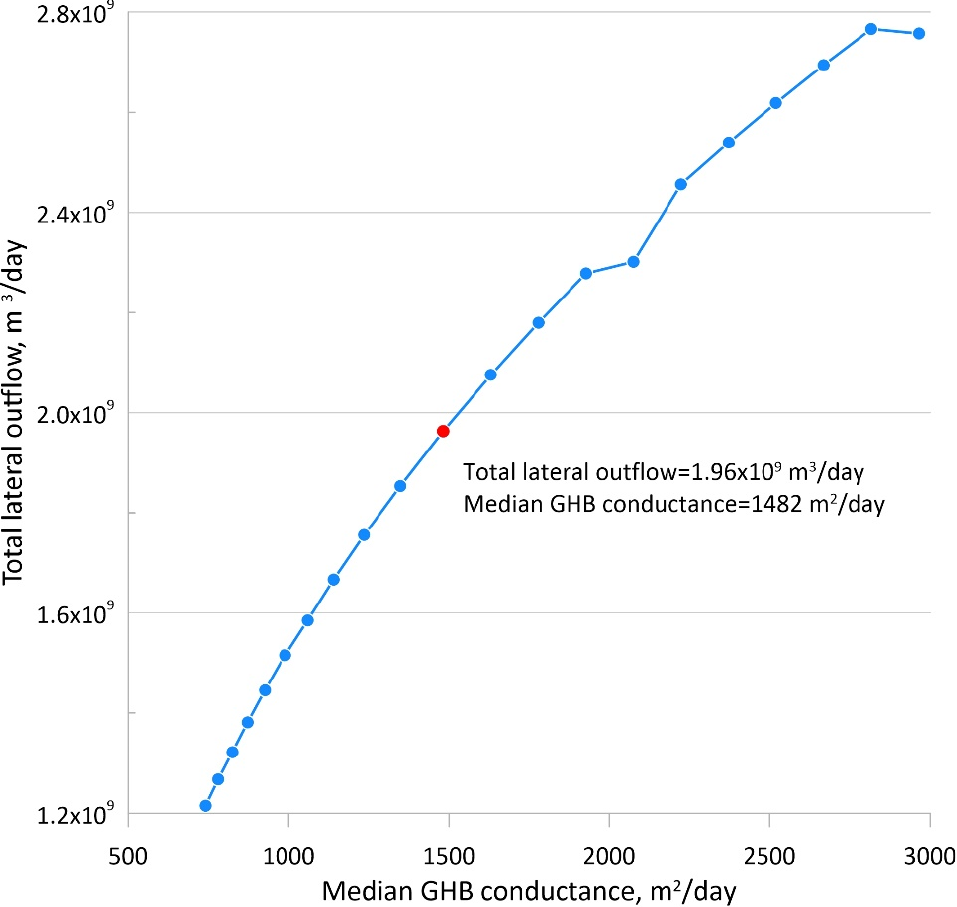
Figure 17. Sensitivity of the model total lateral outflow to the median GHB conductance. The red dot represents the value of the median GHB conductance selected during calibration and the corresponding total lateral outflow.